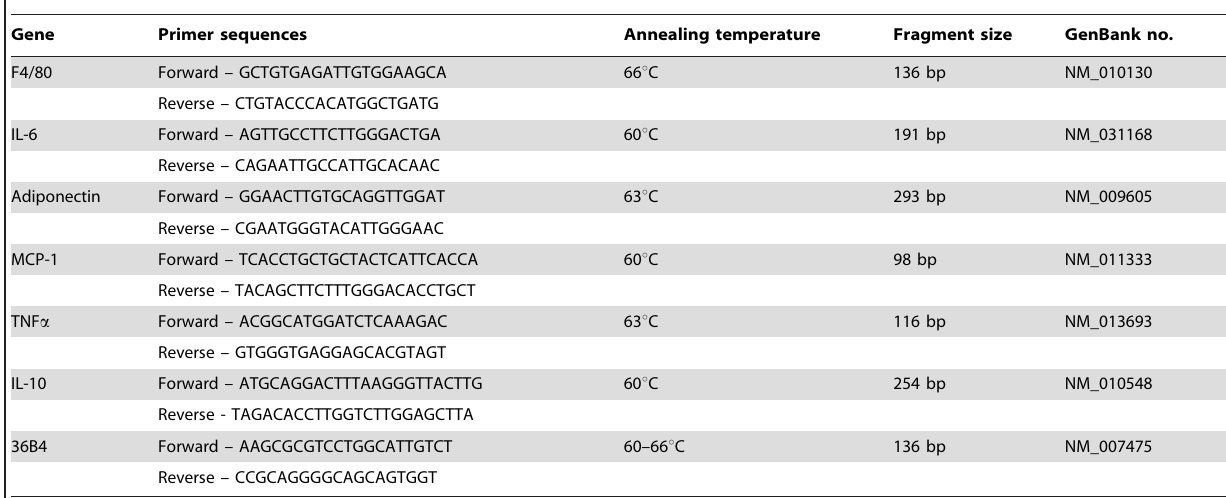
Table 1. Gene and primer information for qRT-PCR.